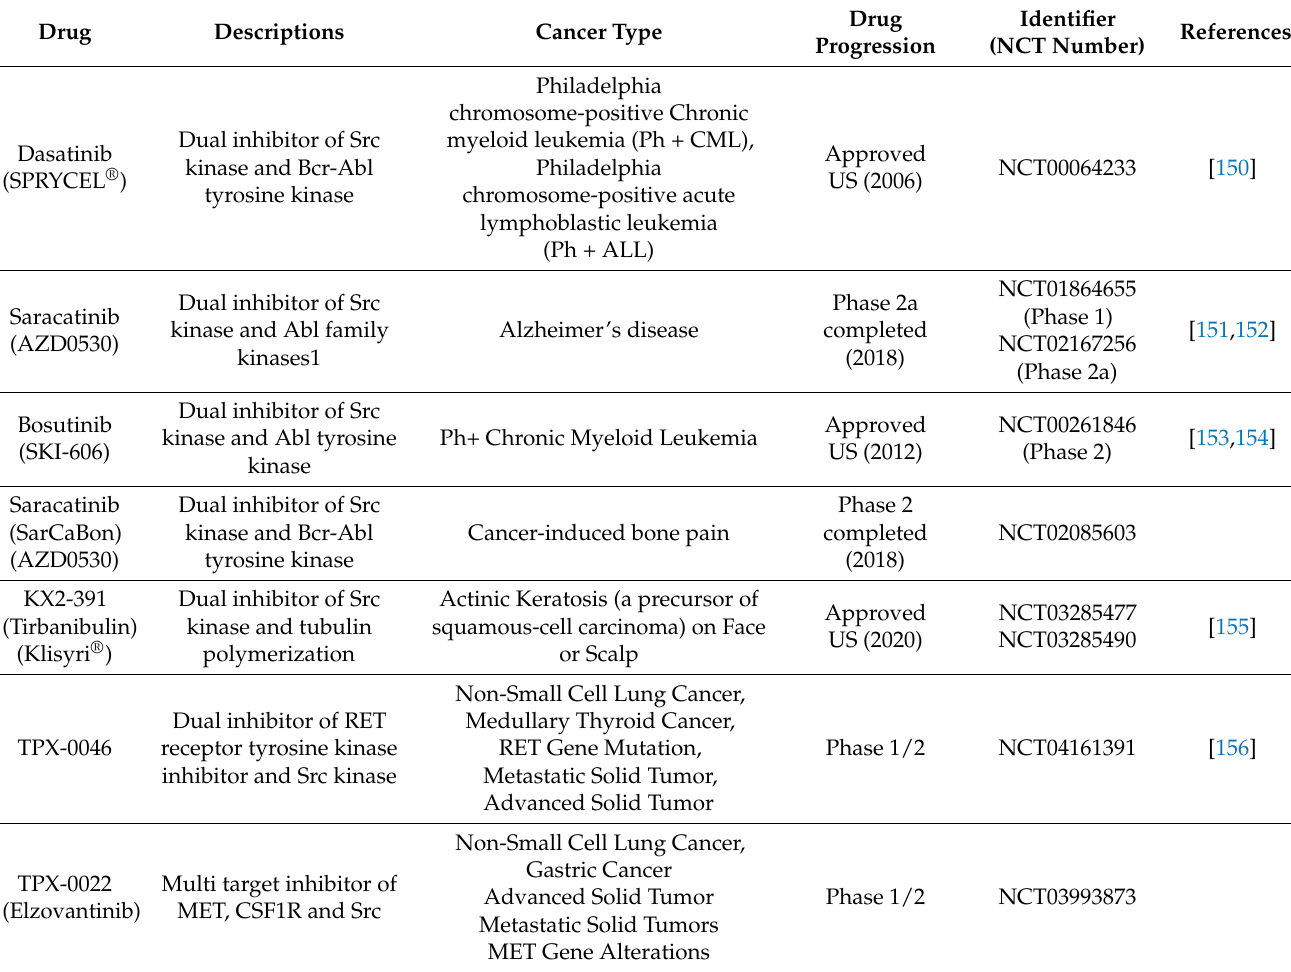
Table 4. Approved src kinase inhibitors as therapeutics and drugs in clinical trials.